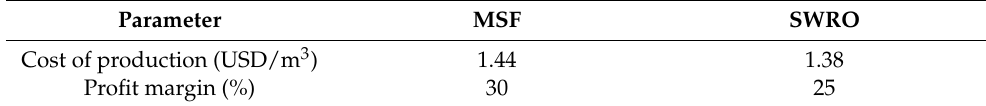
Table 7. Freshwater price economics [35].